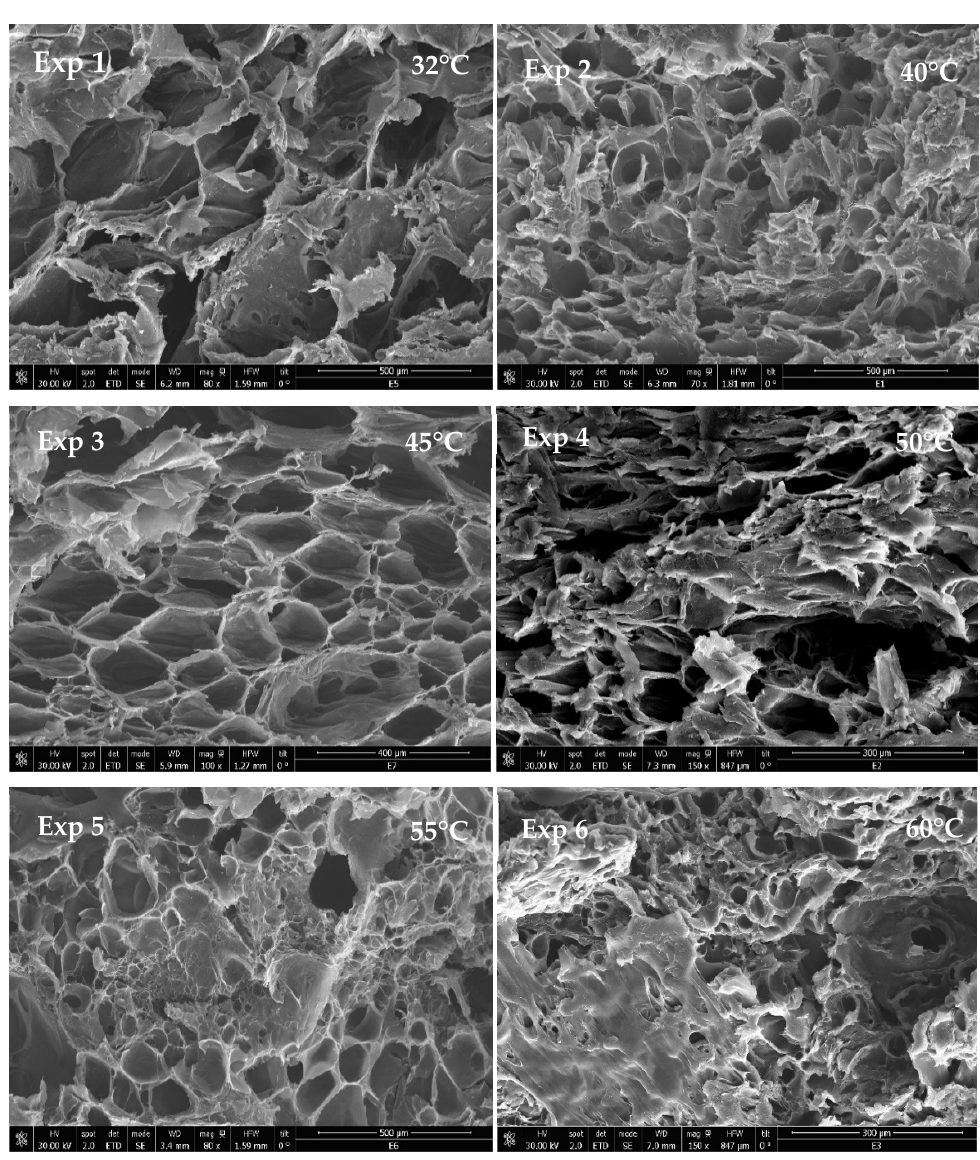
Figure 6. SEM images of formed scaffolds at 120 bar of pressure and 30 min of contact time at different operating temperatures.